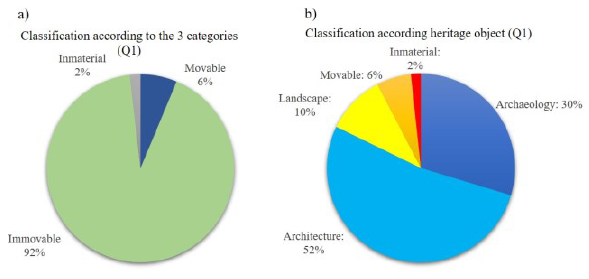
Figure 3: Quantitative graph of the representation of the different categories and classifications (Q1).